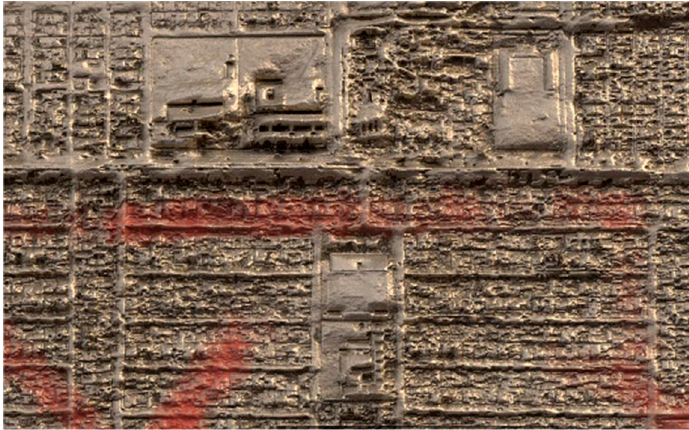
Figure 15. Ronen Sharabani, Basrah #3 (detail), from the series Virtual Territories , 2019. Digital print.